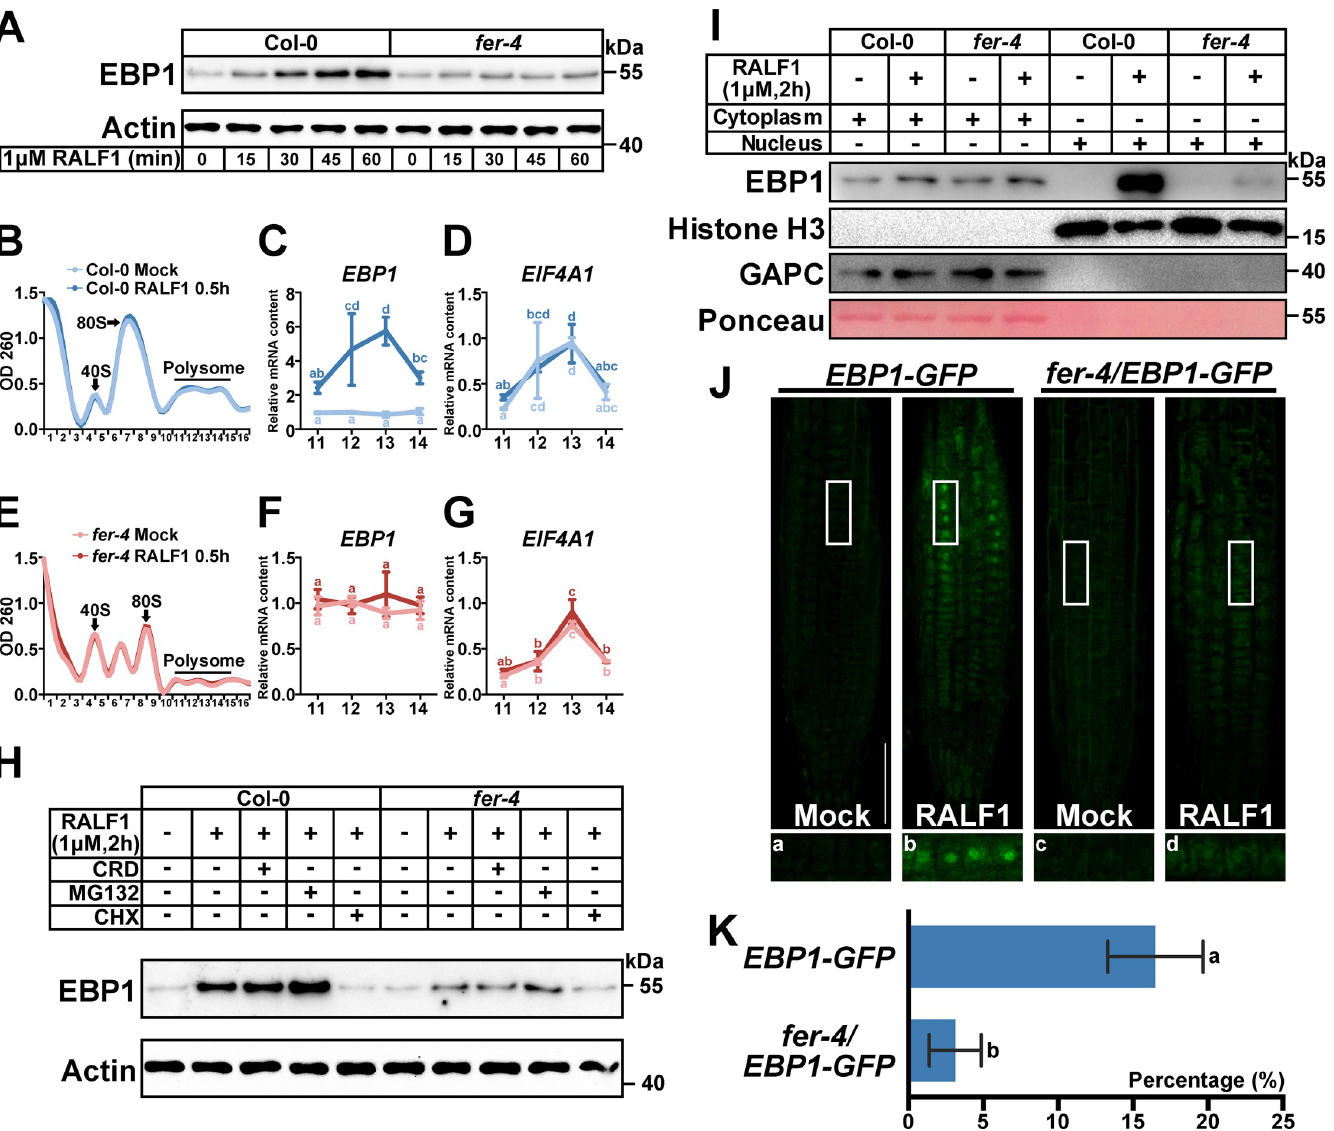
Fig 2. RALF1-induced translation and nuclear accumulation of EBP1 are partially FER-dependent. (A) Time course of EBP1 accumulation in Col-0 and fer-4 plants after 1 μ M RALF1 treatment. Actin was used as loading control. (B-G) Polysome profiling assay with sucrose density gradient accompanied by qRT-PCR to analyze the translational status of EBP1 and EIF4A1 mRNA. The OD260 absorption was monitored together with fractionation. The fractions containing 40S, 80S of ribosome, and polysomes in Col-0 (B) and fer-4 (E) (with or without 1 μ M RALF1 treatment for 30 minutes, respectively) are indicated. The abundance mRNA in the fractions (11–14) of EBP1 (C, F) and EIF4A1 (D, G) were detected by qRT-PCR. Actin was used as a reference gene. Three biological replicates were performed, and similar results were obtained. (H) RALF1 (1 μ M for 2 hours) accelerates EBP1 mRNA translation, which was abolished by CHX. Actin was indicated as a loading control. (I) Immunoblot analyses of EBP1 in both nuclear and nuclei-depleted soluble fractions from RALF1 treated (1 μ M for 2 hours) or untreated Col-0 and fer-4 , respectively. Antibody against Histone H3 was used to mark the nucleus fraction. Antibody against GAPC and Ponceau S staining was used to mark cytosolic fraction. (J) RALF1-induced nucleus accumulation of EBP1-GFP in root cells of 7-DAG seedlings harboring 35S :: EBP1-GFP ( EBP1-GFP for short) and fer-4 / EBP1-GFP , respectively. Seedlings were treated with 0 μ M or 1 μ M RALF1 peptide for 2 hours. Close-up of the pictures are selected (with white frames) and displayed in a–d, respectively. All the fluorescence images were taken using the same parameter of laser scanning confocal microscope. Three independent lines of 35S :: EBP1-GFP were analyzed, and similar results were obtained. Bar = 50 μ m. (K) Percentages of cells with GFP signals in the nucleus. At least 2,300 cells were quantified from 19 independent roots for each genotype per experiments. Three biological replicates were done independently, and similar results were obtained. At least five biological replicates of panels A, H, and I were performed, and similar results were obtained. Data represent means. Data points are means +/ − SD. Values with different letters are significantly different ( P < 0.05) from each other, tested by one-way ANOVA. Numerical data used to generate the plot in B-G and K are provided in S1 Data. CHX, cycloheximide; CRD, cordycepin; DAG, day after germination; EBP1, ErbB3-binding protein 1; FER, FERONIA; GAPC, cytosolic glycolytic GAPDHs; GFP, green fluorescent protein; qRT-PCR, quantitative reverse transcription PCR; RALF1, rapid alkalinization factor